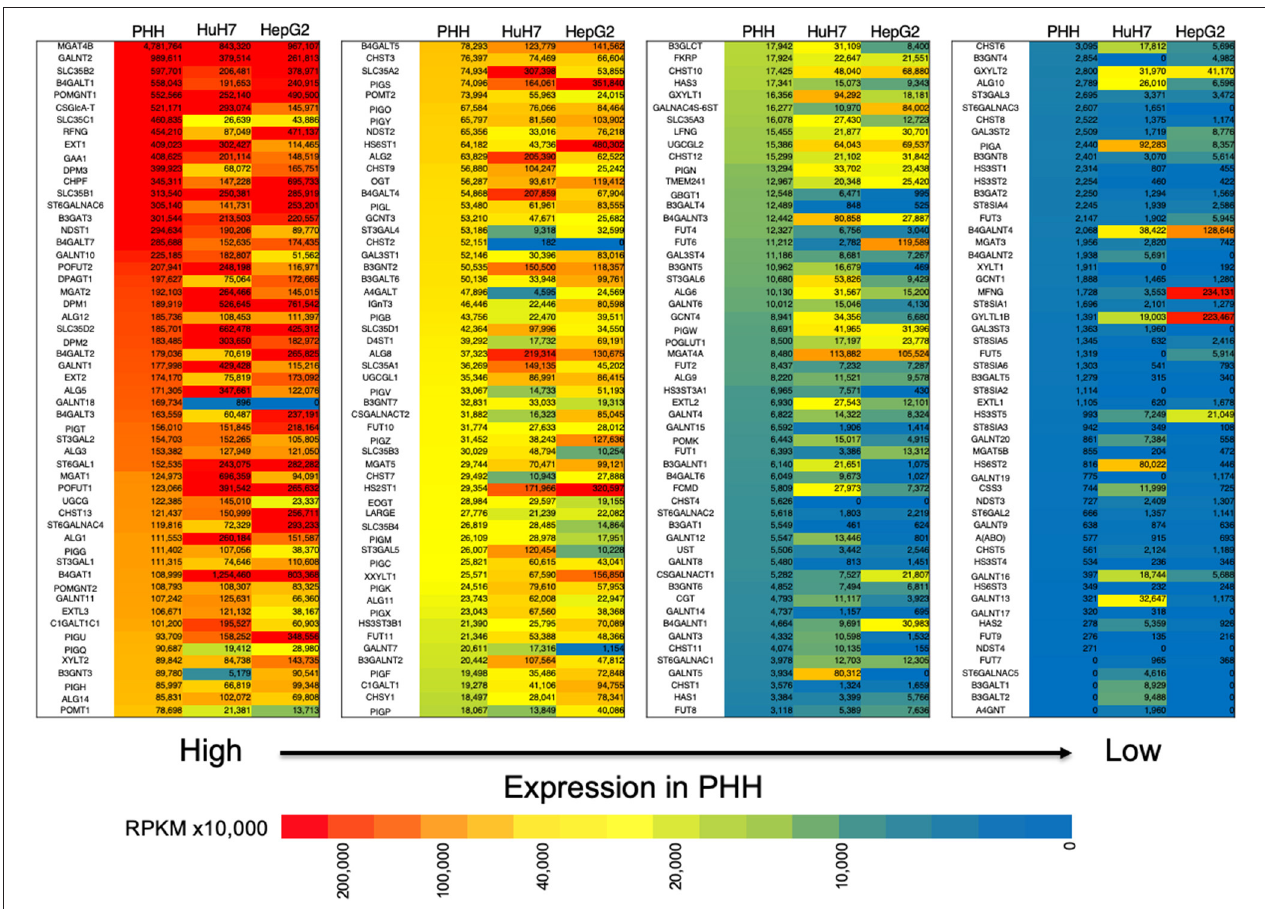
FIGURE 2 | Expression of glycogenes in liver cells and hepatocarcinoma cell lines measured by RNA-Seq. The read number of the glycogenes from the RNA-Seq results of primary human hepatic (PHH) cells, HuH7 cells and HepG2 cells was used to calculate RPKM per cell line. The glycogenes are aligned from the highest to the lowest expression based on RPKM from PHH cells. Red indicates high expression levels while blue indicates low. The numbers in the figure are shown as RPKMx10,000.